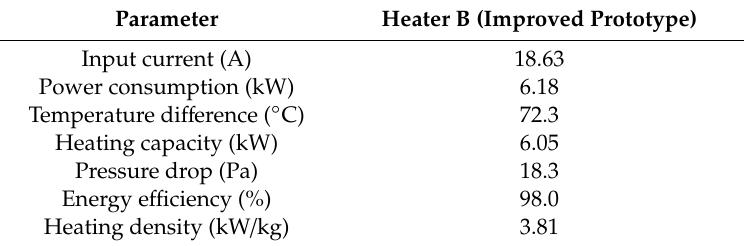
Table 5. Heating performance of PTC heater B (improved